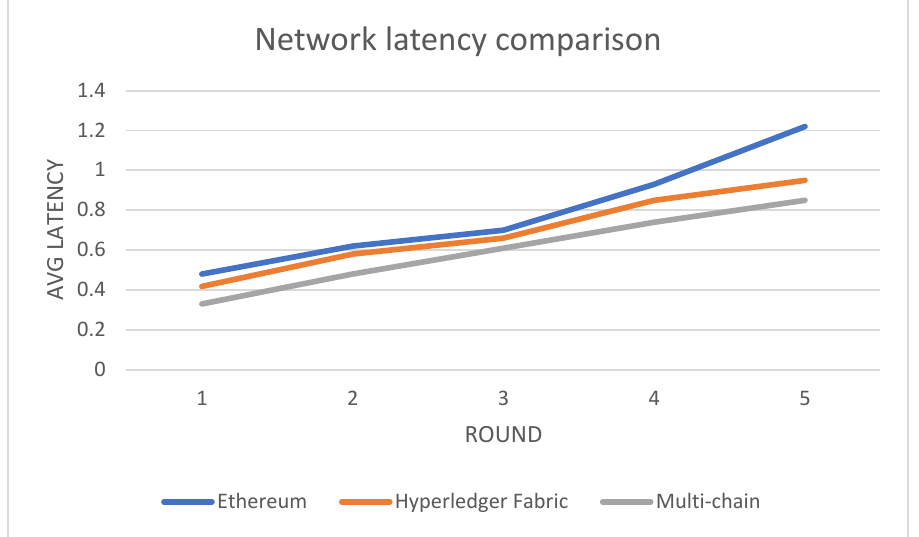
Figure 31. Comparison of three types of network transaction throughput performance.